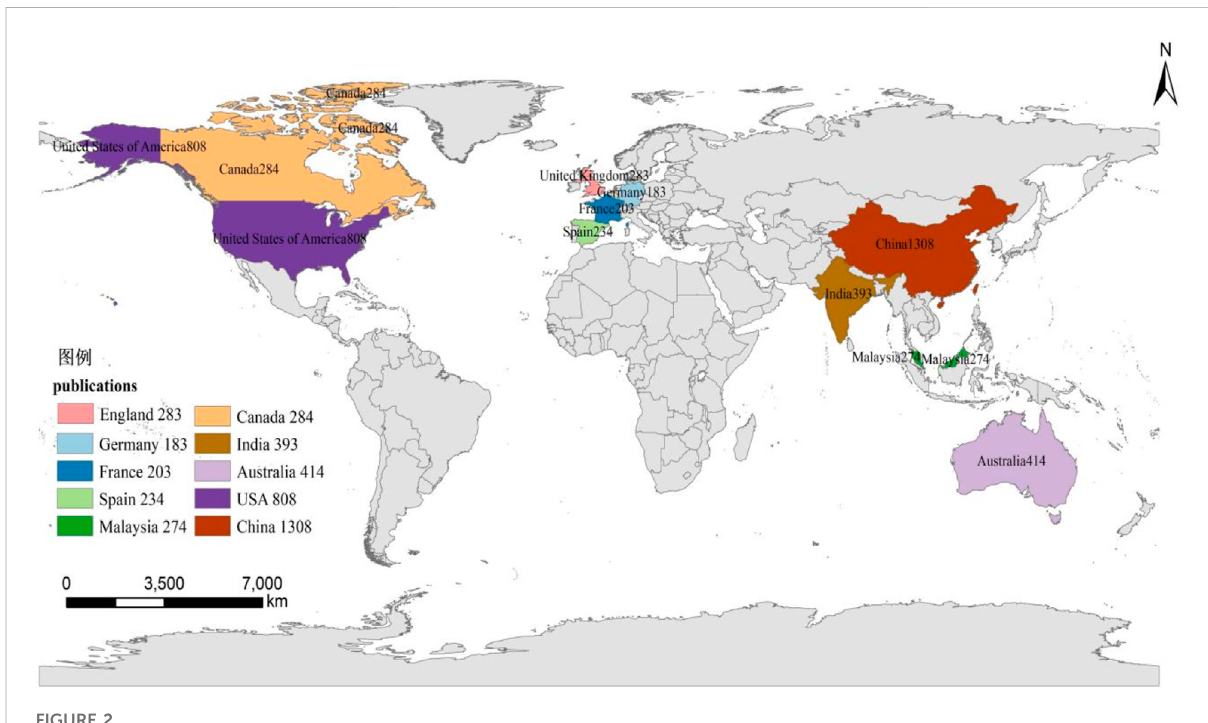
FIGURE 2 Regional distribution of countries with high ecological concrete